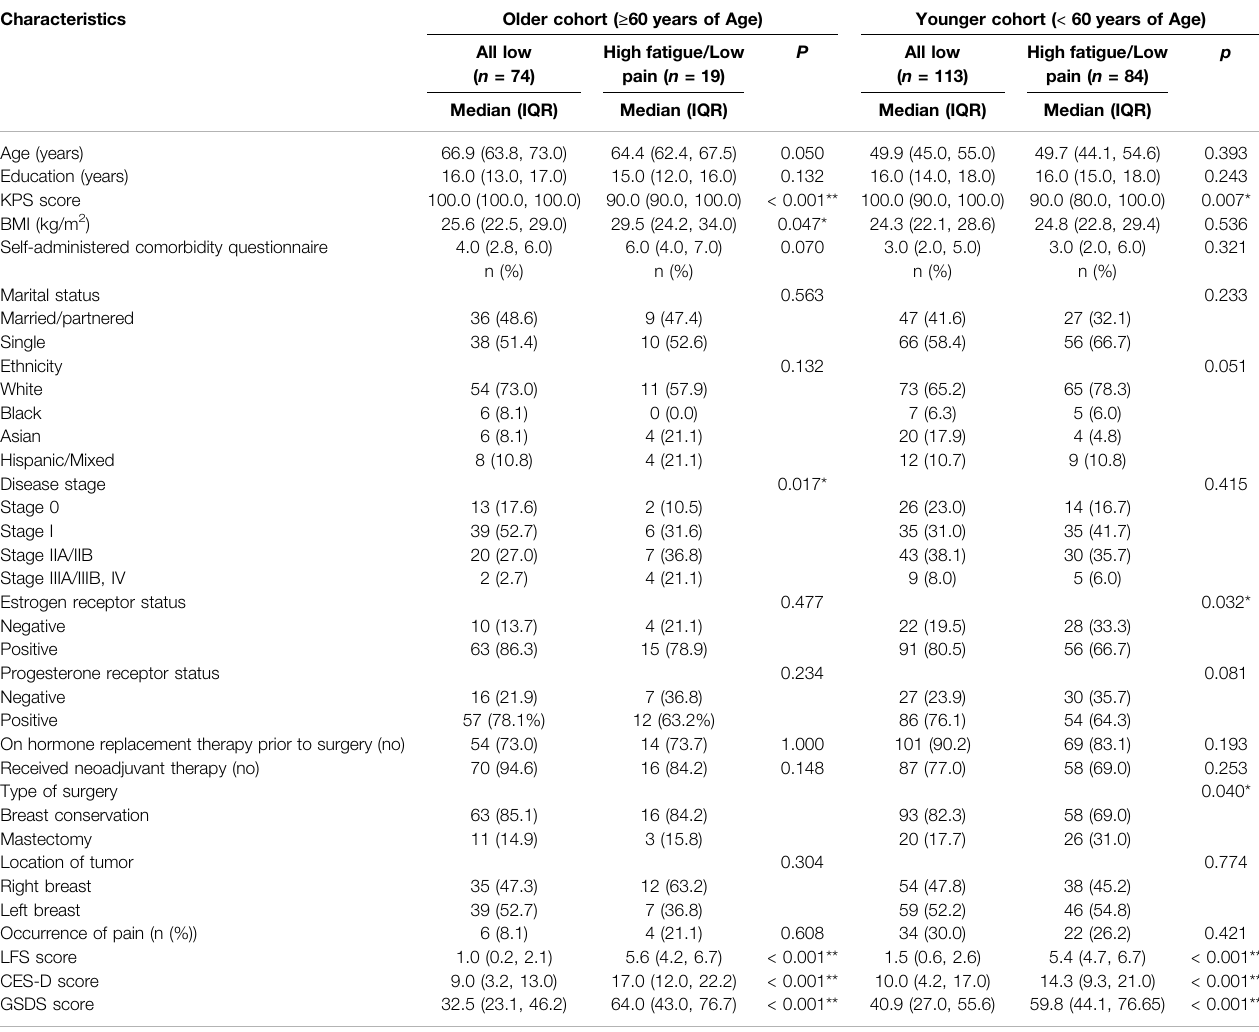
TABLE 1 | Demographic and clinical characteristics.